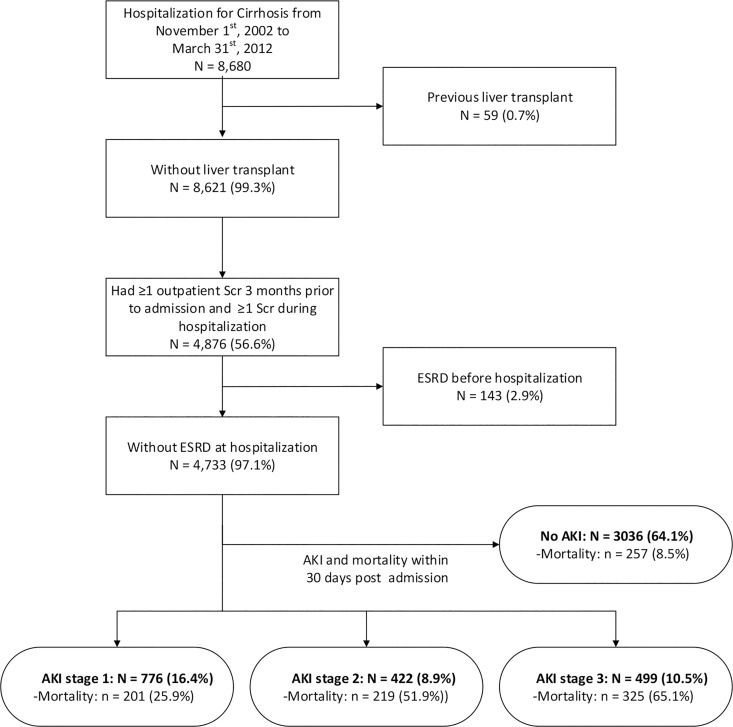
Study flow chart.SCr, serum creatinine; ESRD, end-stage renal disease; AKI, acute kidney injury.